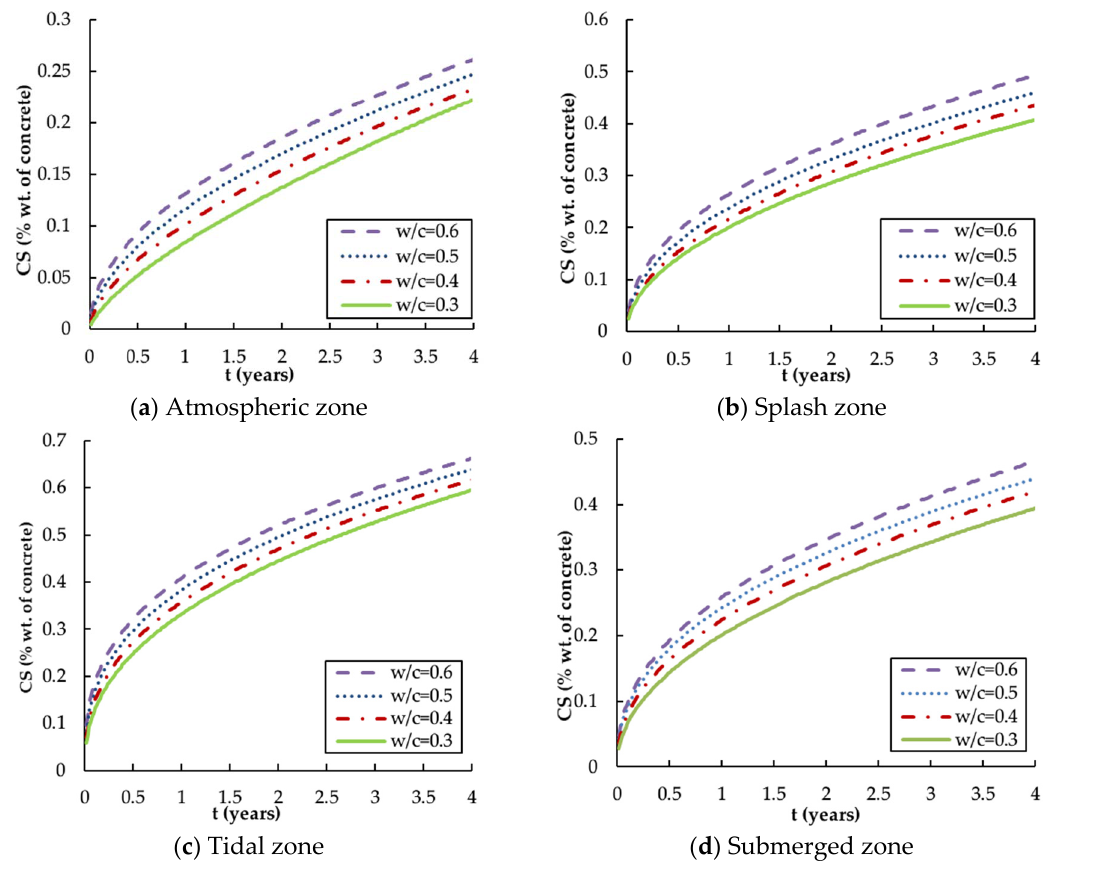
Figure 3. Influence of 𝑤/𝑐 ratio on surface chloride content versus time for different zones: ( a ) Atmospheric zone; ( b ) Splash zone; ( c ) Tidal zone; ( d ) Submerged zone.